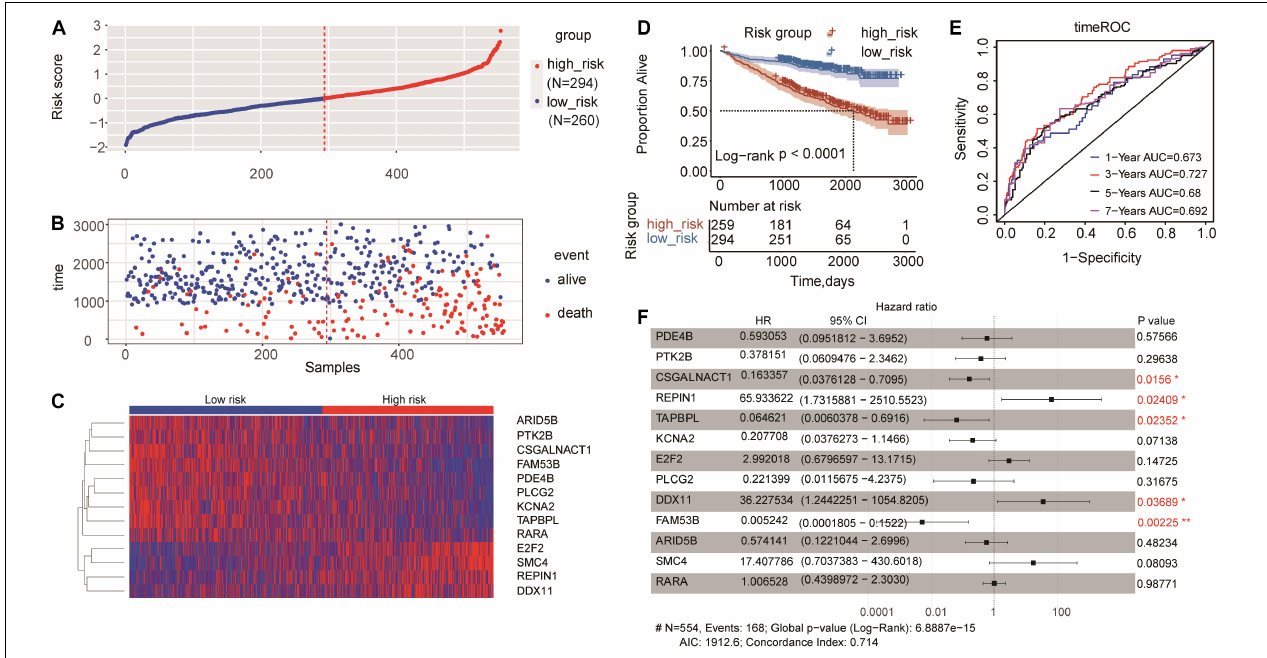
FIGURE 3 | Risk score model based on 13-gene signature in MM. (A) 13-gene risk score distribution. Multiple myeloma patients were divided into the high-risk group and low-risk group based on the cut-off value. (B) The survival status and time in high-risk and low-risk groups. (C) The expression profiles of the 13 genes in high-risk and low-risk groups. (D) Kaplan-Meier analysis of the 13-gene risk score model to predict patient survival. Upper: Kaplan-Meier curve of the overall survival between the high-risk and low-risk groups. Lower: the number of patients at risk in the high-risk and low-risk groups at different time points. (E) Time-dependent ROC curves for the 13-gene model to predict patient survival. (F) Multivariate Cox regression analysis of the 13 genes (* p < 0.05 and ** p < 0.01). Hazard ratio and 95% CI are showed in the figure. Global log-rank p , C-index and AIC were also calculated and